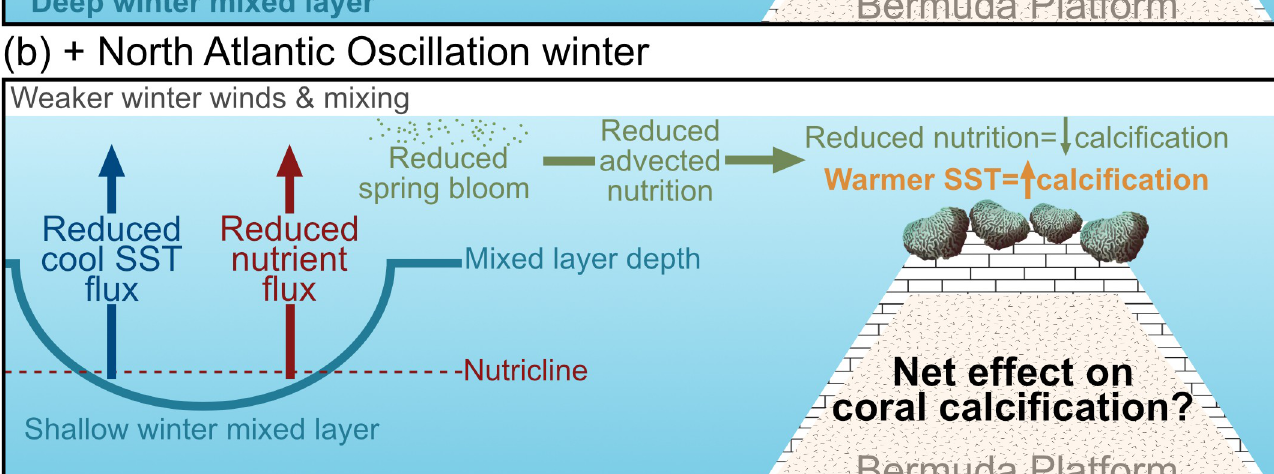
S1 Fig. Coral core standards density curves are plotted for each scan. Each circle represents the mean CT-scan luminance and measured density for each coral standard. Solid black line